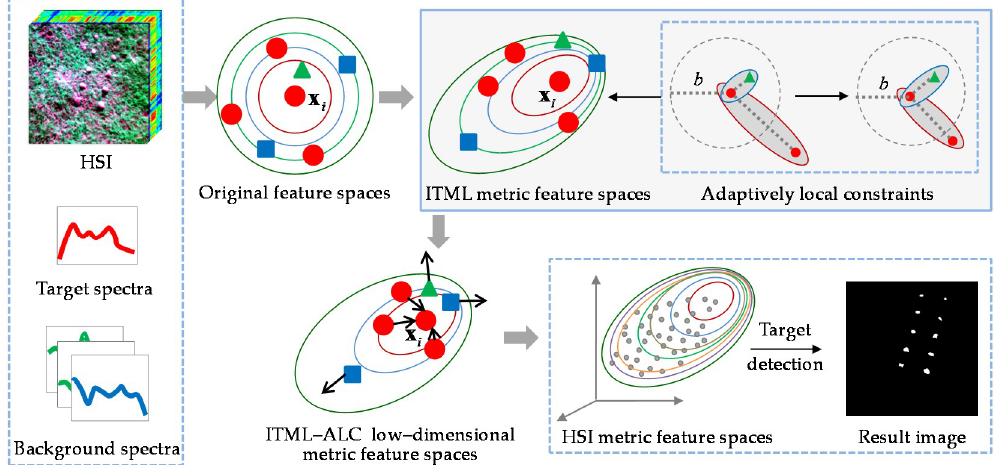
Figure 1. Schematic illustration of adaptive information-theoretic metric learning with local constraints (ITML-ALC) algorithm for HSI target detection.